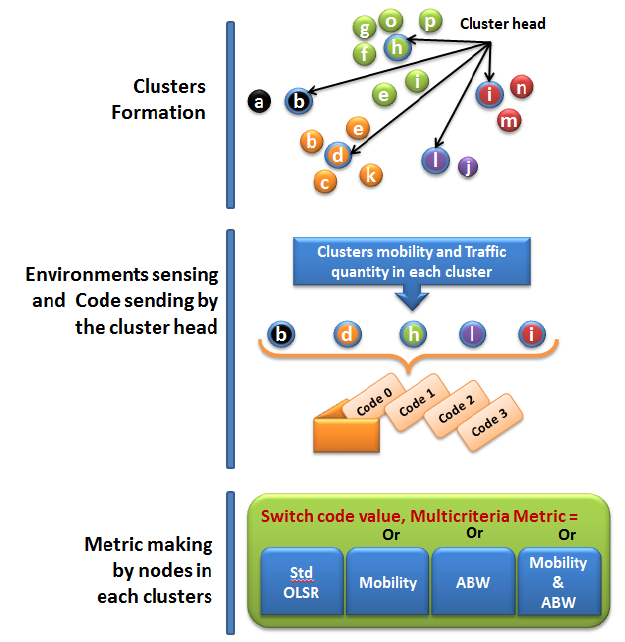
Fig. 3. Multi-objective metric computation